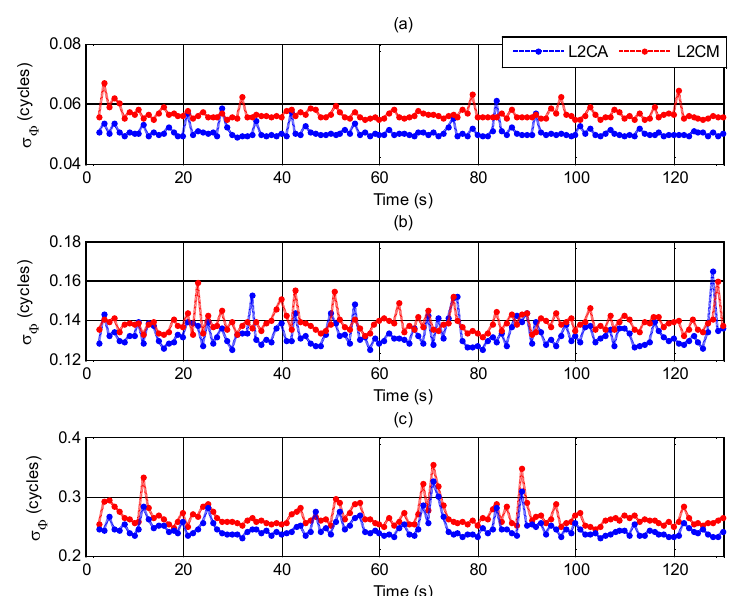
Figure 5. Sky plot of GPS satellites in polar areas.